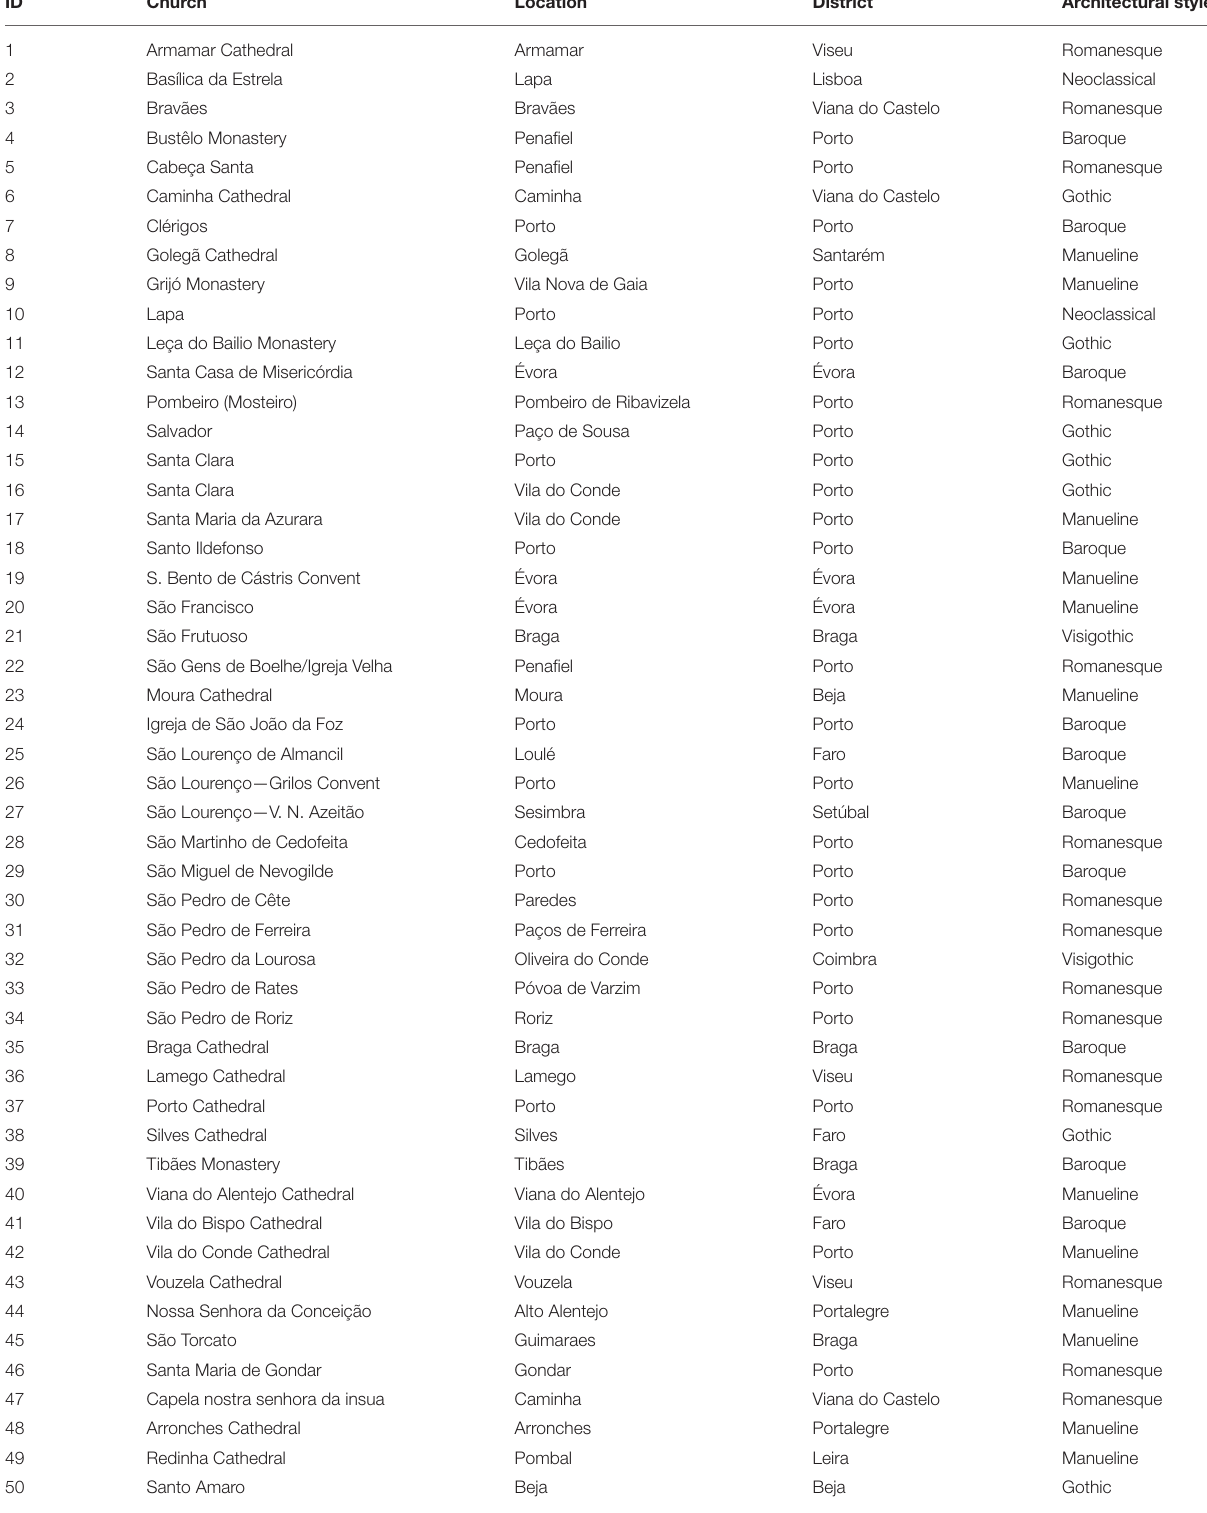
TABLE 6 | List of the sampled churches data illustrated in Figure 2